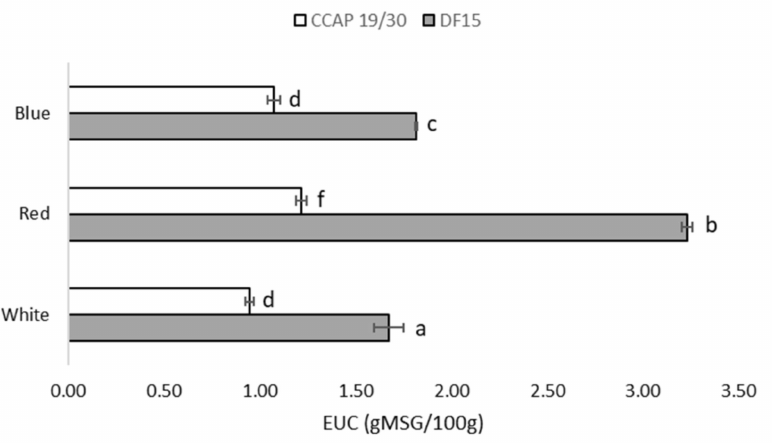
Figure 3. Equivalent umami concentration (EUC) of D. salina DF15 and D. salina CCAP19/30 at the end of the experiment. Cultivation was conducted at 25 ◦ C, pH 7.5 and 100 rpm mix- ing using white, red and blue light at 200 µ mol photons m − 2 s − 1 . Data are expressed as the means ± standard deviation. The different letters indicate statistically different groups (significance level at p -value <